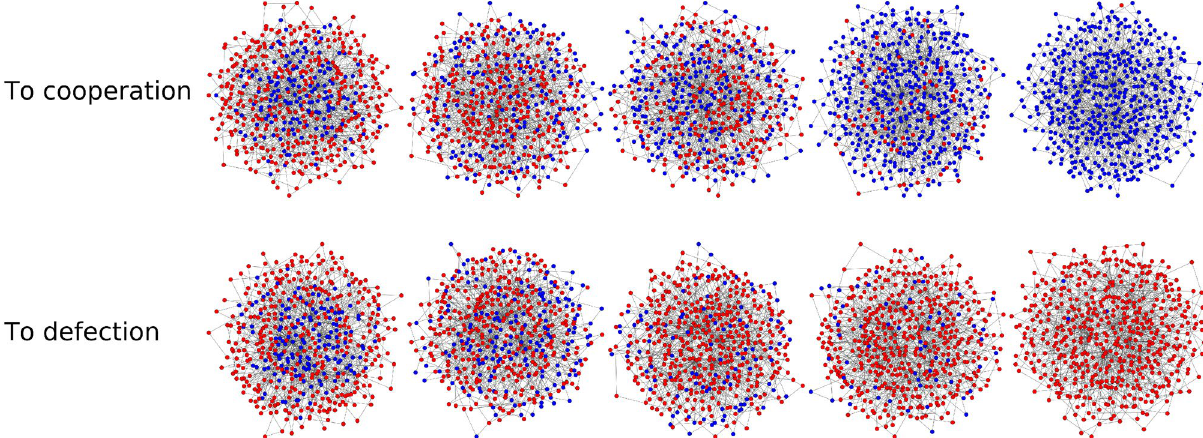
Figure 4. The typical trajectories of the two possible outcomes of when cooperators are introduced in a population of defectors. The initial density of cooperators is ρ = 30% , and the network structure is a scale-free. The restoration of cooperation (upper panel) and the collapse of cooperation (lower panel) are shown in the case when the initial cooperators have been added using the ranking based on degree, with weak selection strength and the game is the prisoner’s